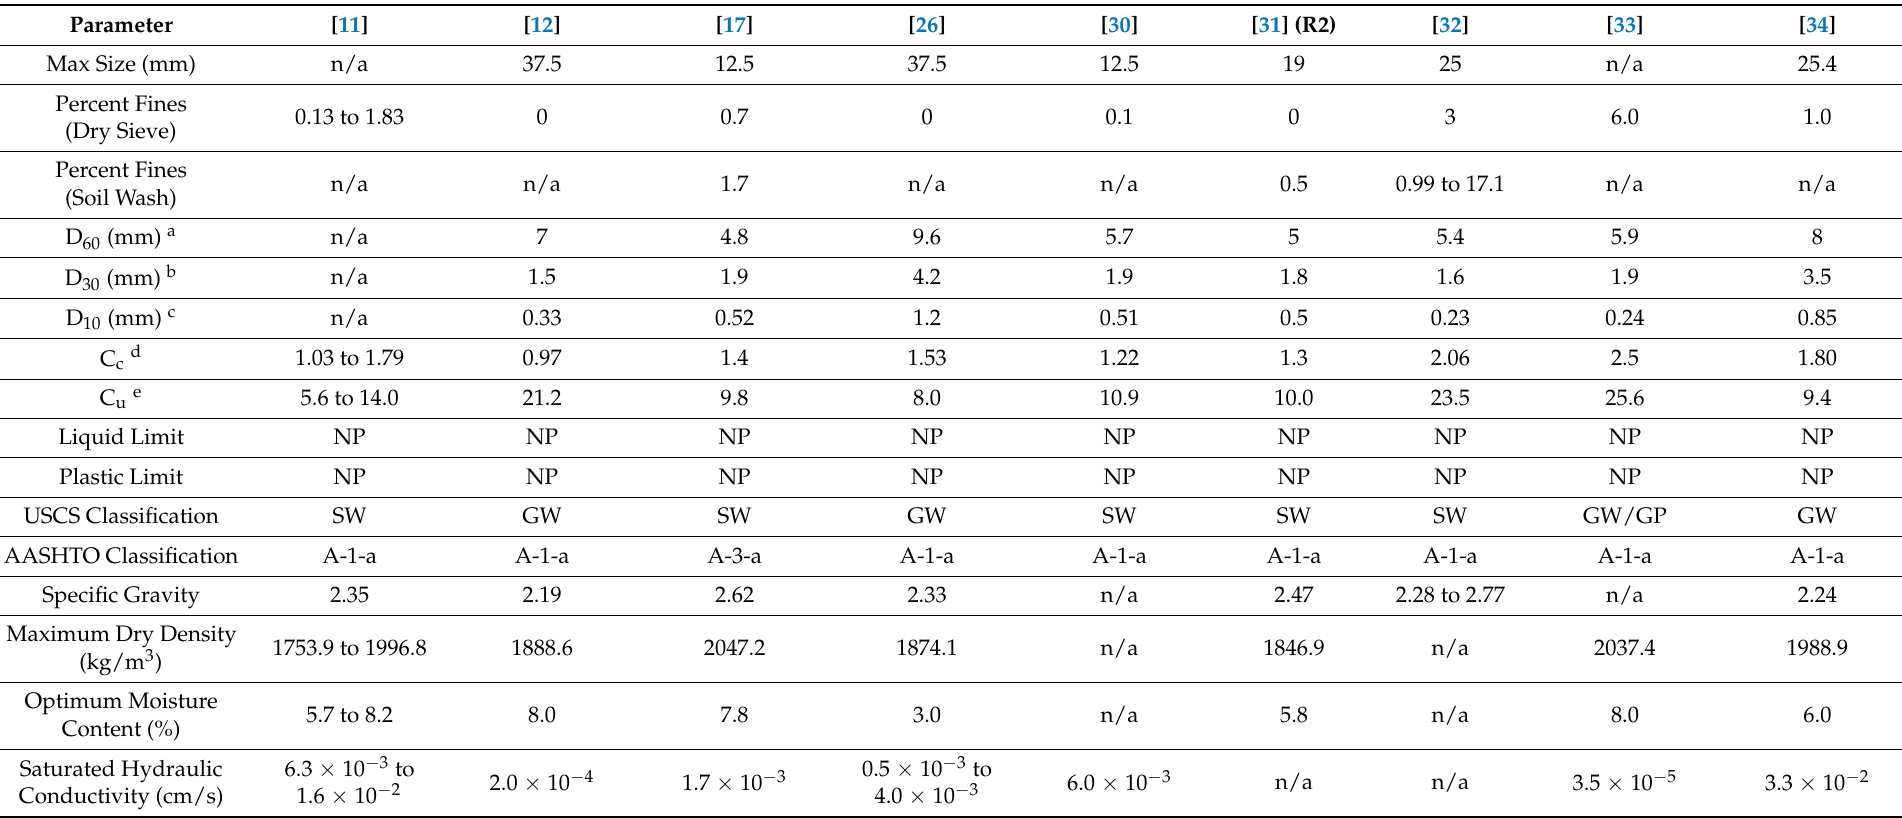
Table 2. Summary of geotechnical properties of RAP reported in nine experimental